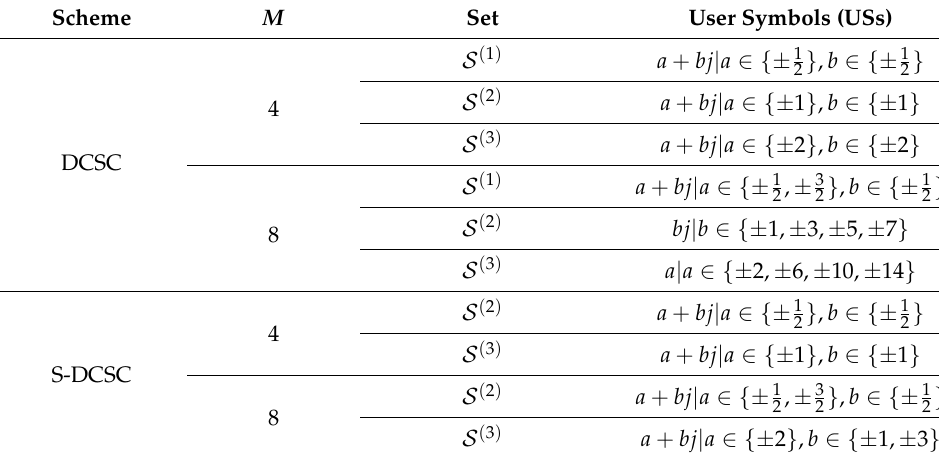
Table 2. The USs obtained by decomposing the